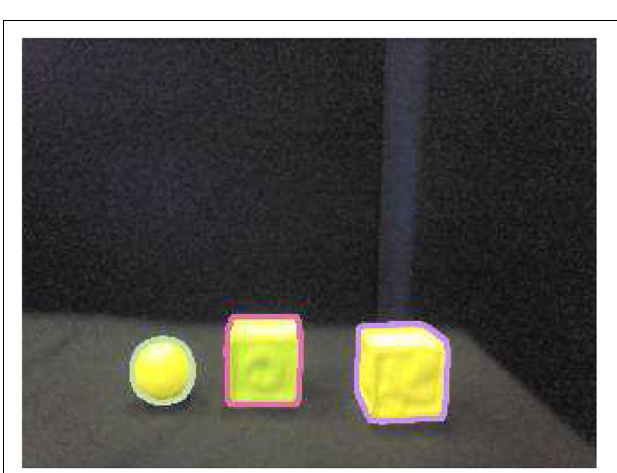
FIGURE 3 | Contours extracted from the image. We used a Canny filter as implemented in the OpenCV (version 2.4)